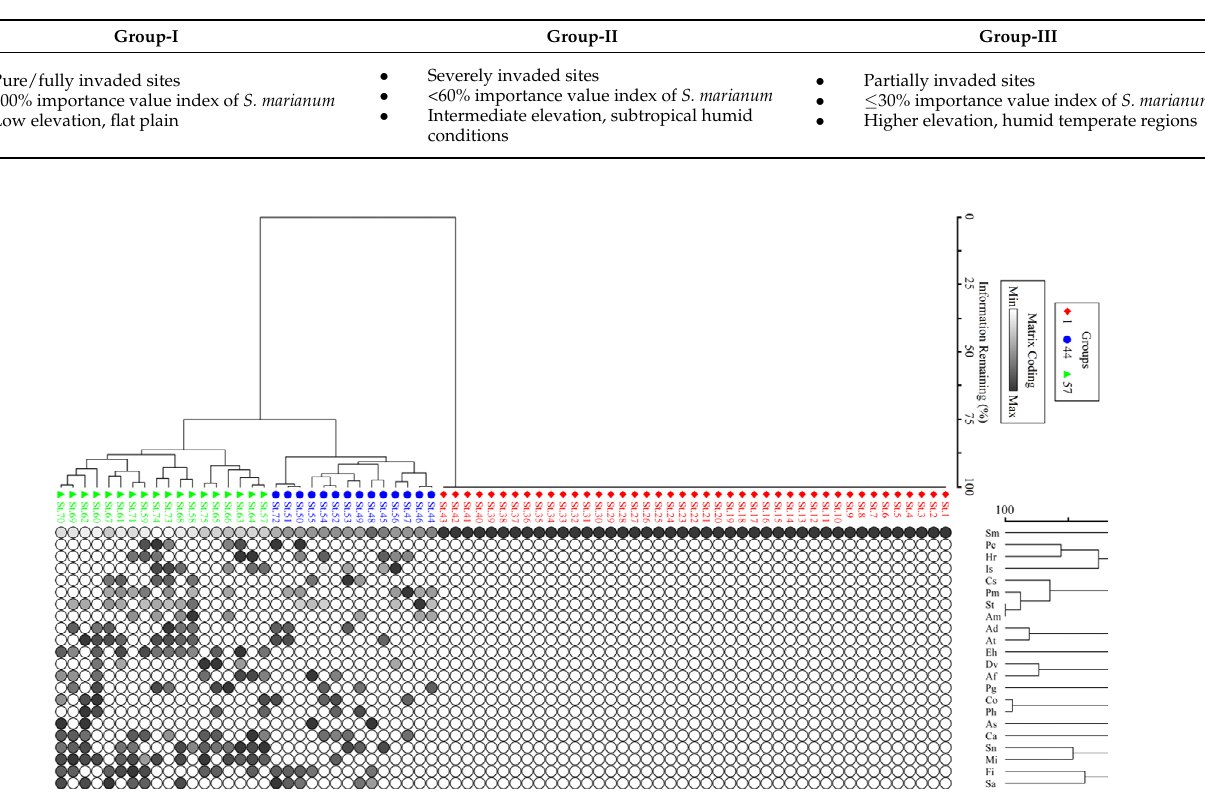
Figure 2. Cluster dendrogram of the Silybum marianum communities for classification and separa- tion.